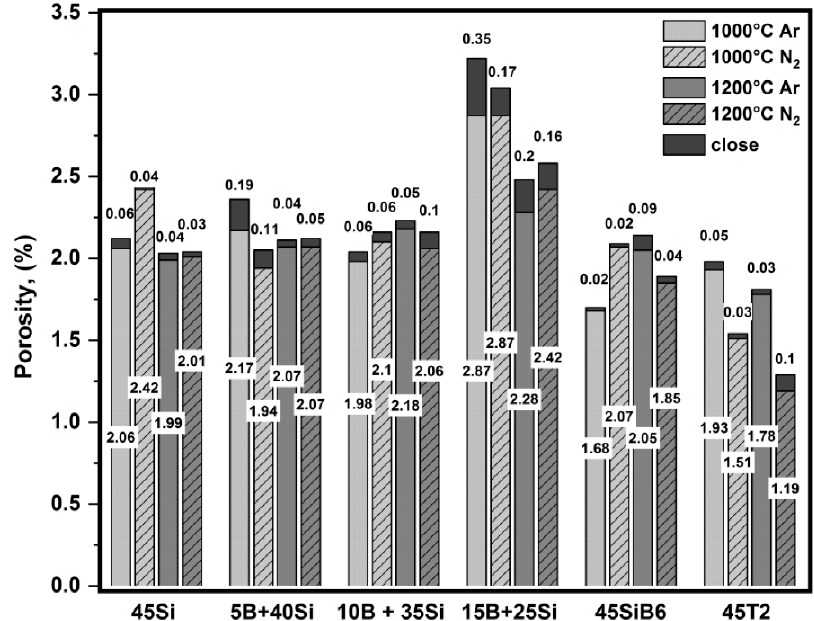
Figure 3. Open and closed porosity of samples after pyrolysis in Ar or in N 2 at 1000 °C or 1200 °C; dark part of the bar: closed porosity.